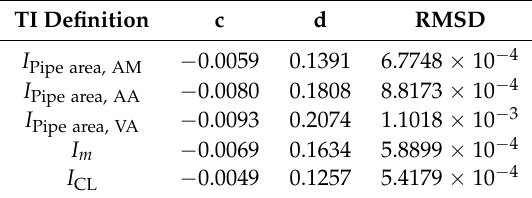
Table 2. Log-law fit constants, smooth